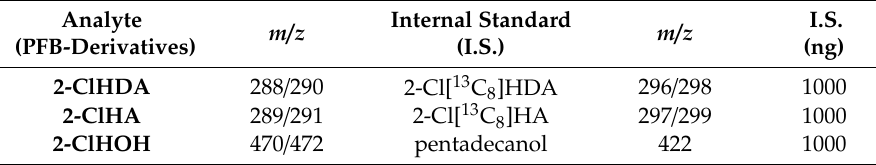
Table 2. Characteristic m / z values used to identify and quantify chlorinated